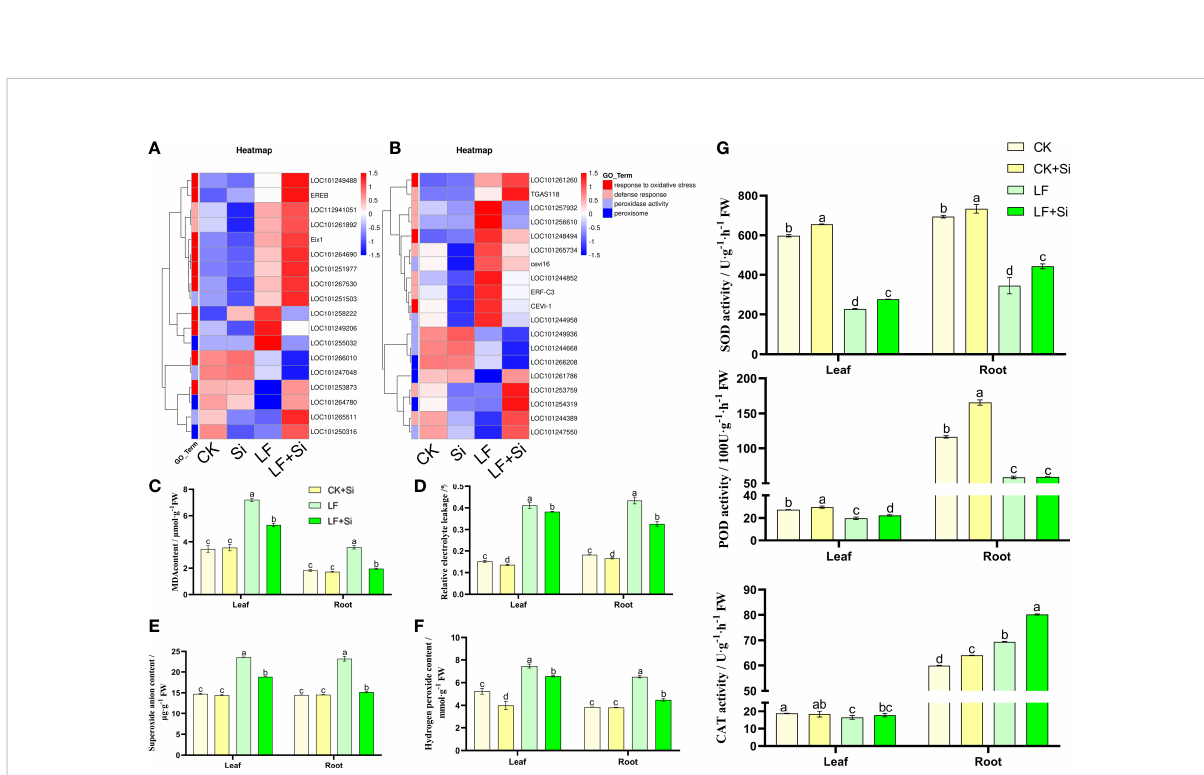
FIGURE 5 Effects of silicon application on antioxidant defense in tomato under Fe de fi ciency. (A) Heat map of antioxidant-related differentially expressed genes in the leaf. (B) Heat map of antioxidant-related differentially expressed genes in the root. (C) malondialhyde (MDA) content. (D) Relative electrolyte leakage. (E) Hydrogen peroxide content. (F) Superoxide anion content. (G) Antioxidant enzyme activity. Each data point represents the mean of three independent biological replicates (mean ± SD). Different letters above the bars indicate statistically signi fi cant differences ( P <0.05).